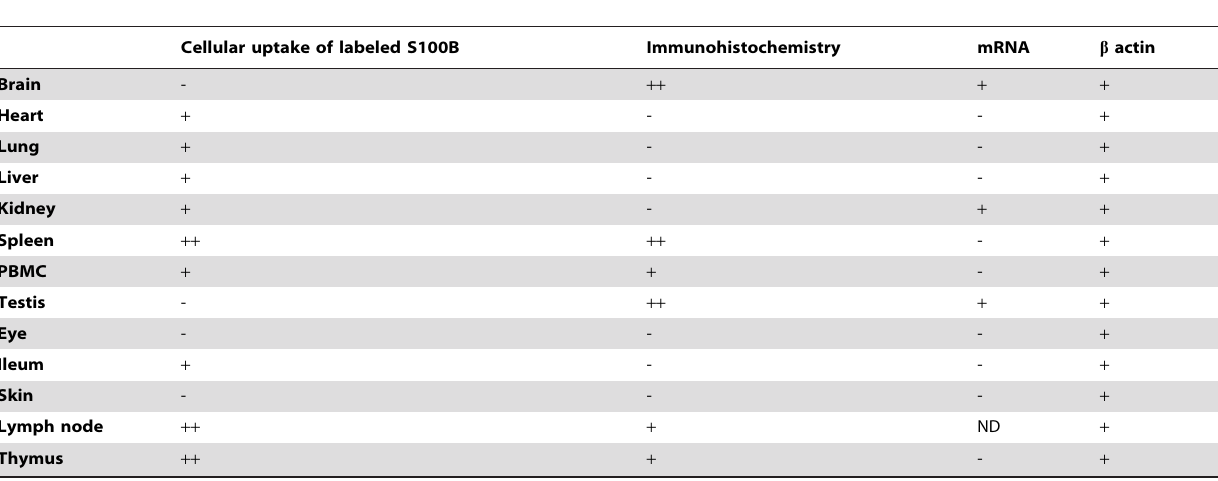
Table 1. Summary of experimental results testing for the presence of S100B at the protein, mRNA levels or after injection of labeled